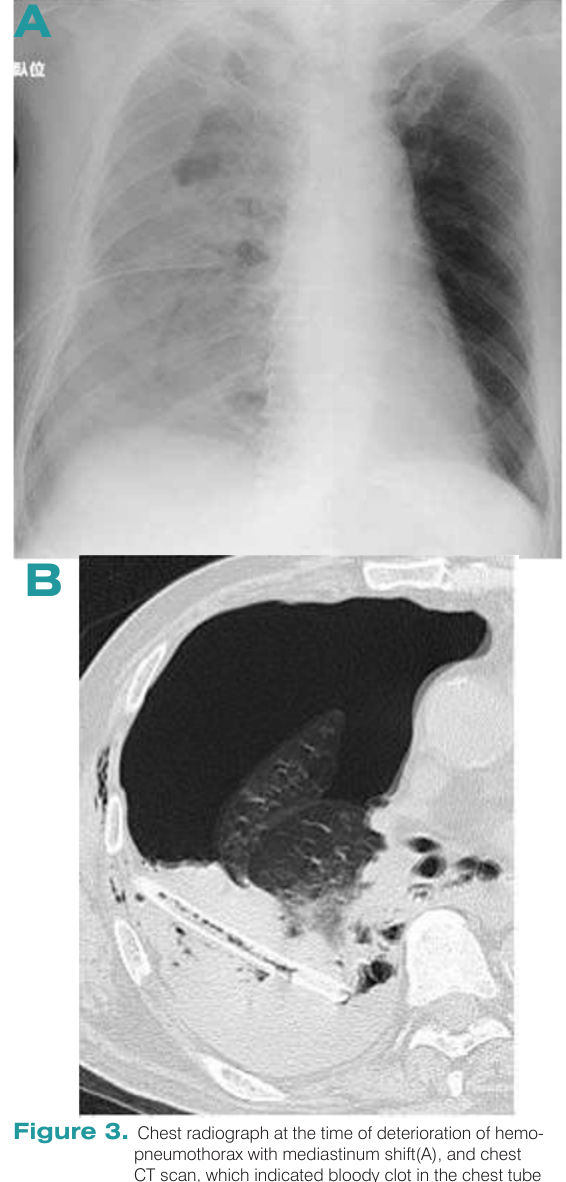
Figure 3. Chest radiograph at the time of deterioration of hemo- pneumothorax with mediastinum shift(A), and chest CT scan, which indicated bloody clot in the chest tube inserted and deterioration of pneumothorax with medium amount of pleural fluid